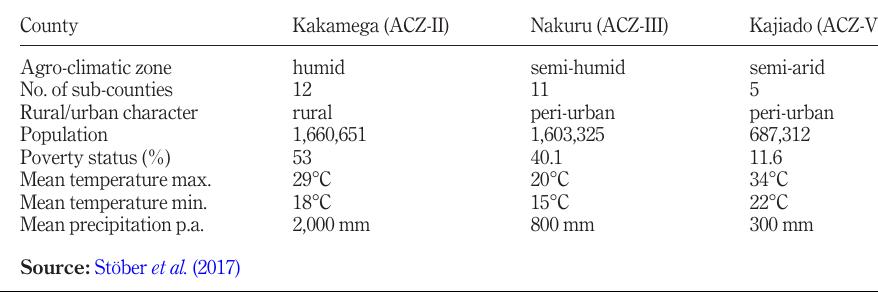
Table I. Main features of the study